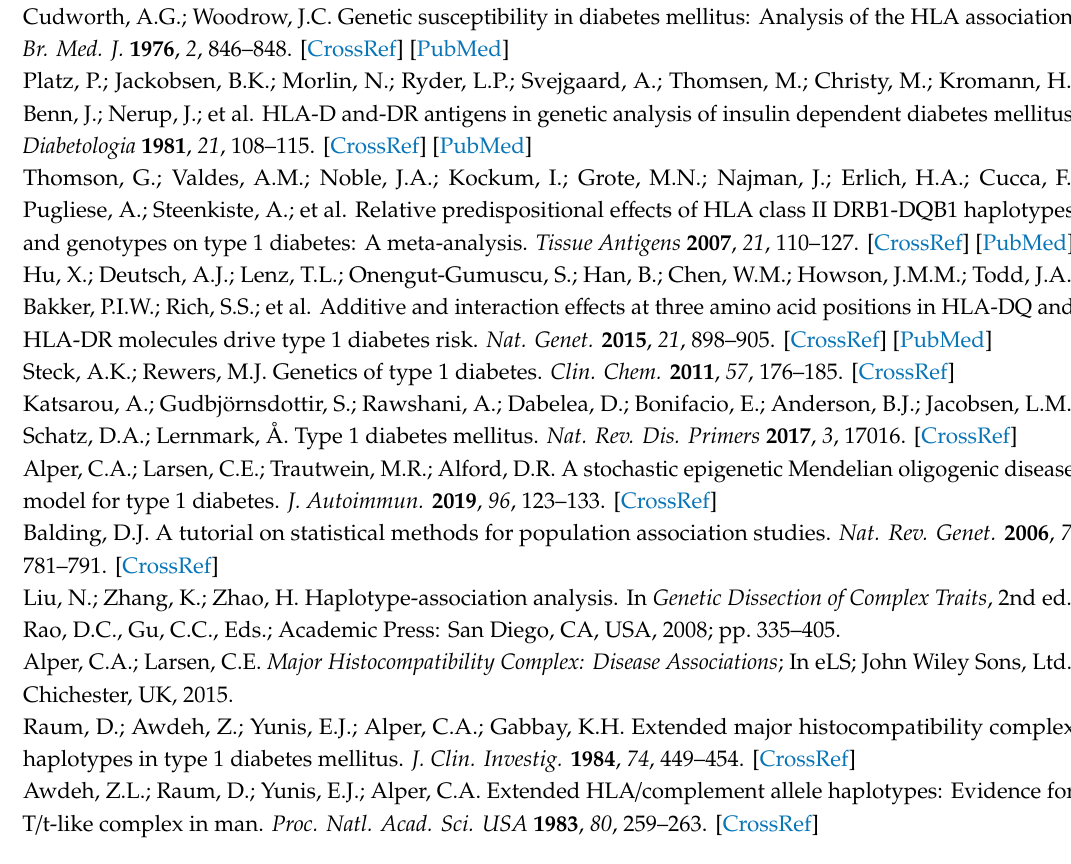
Table S1: SNPs used for edited haplotypes in HLA-DR / DQ region, Table S2: SNP sequences for the most frequent T1DGC ImmunoChip study edited 27-SNP haplotypes, Table S3: Major HLA-DR,DQ haplotypes shared in T1DGC studies: their secondary and unphased 27-SNP haplotypes and their